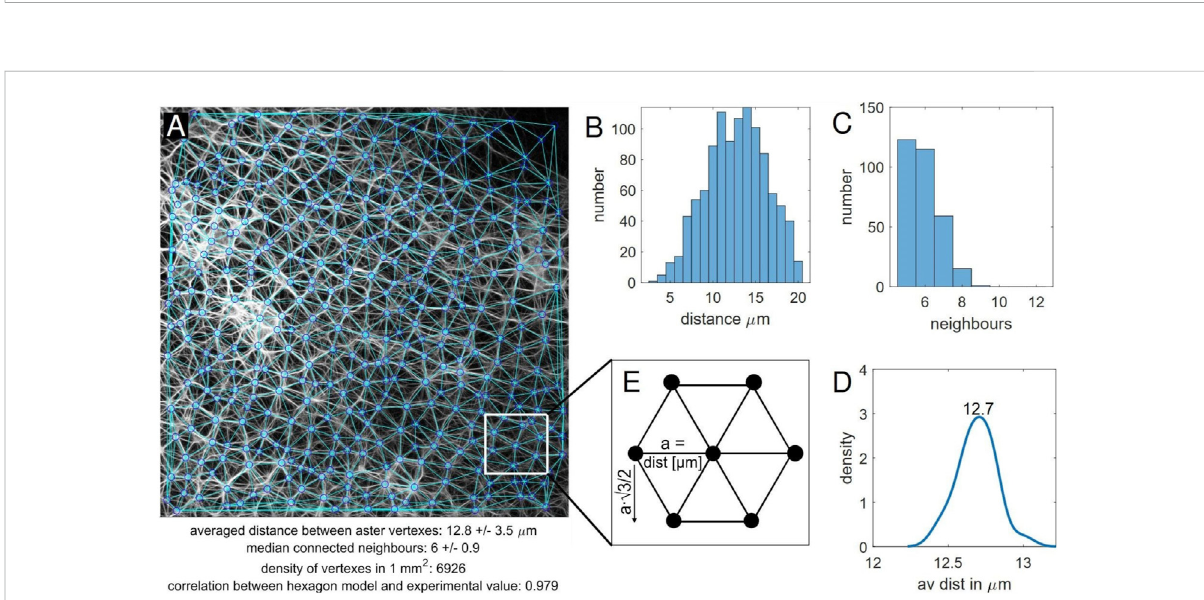
FIGURE 5 Astervertexesrecognitionprogram. (A) Thevertexdetectionandtriangulationre fl ectthenetwork,outcomevaluesoftheanalysisaredisplayed at the bottom. Further shown are the (B) distribution of distances between the aster vertexes, (C) distribution of connected neighbour vertexes. (D) Bootstrapping was performed on the average distances between vertexes of different sections via the built-in Matlab function. A kernel density was determined out of the bootstrapped results. (E) Hexagon model, where the number of vertexes is calculated using the packing